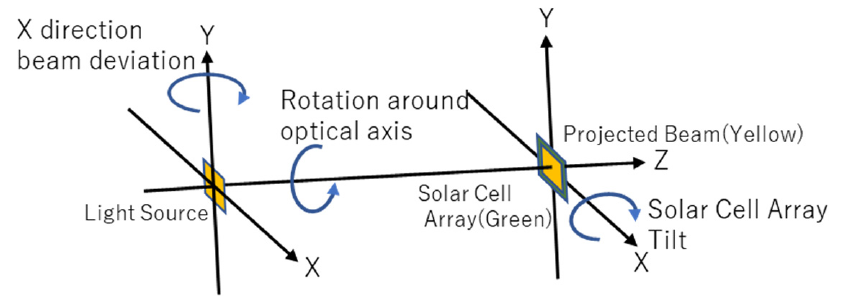
Figure 10. Beam alignment in cooperative OWPT system.